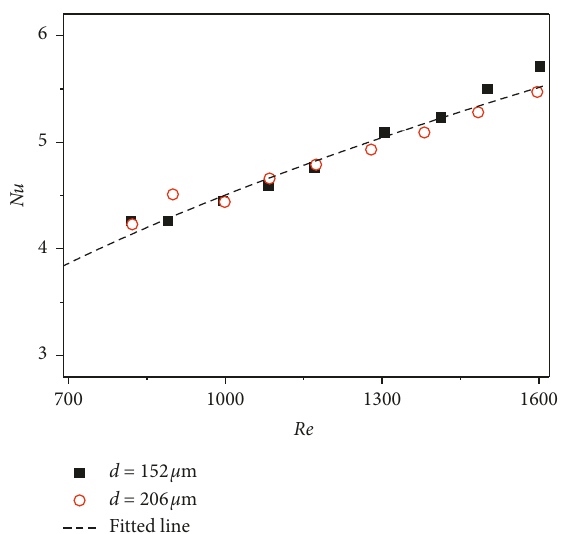
Figure 10: Effect of the Reynolds number on the Nusselt number.